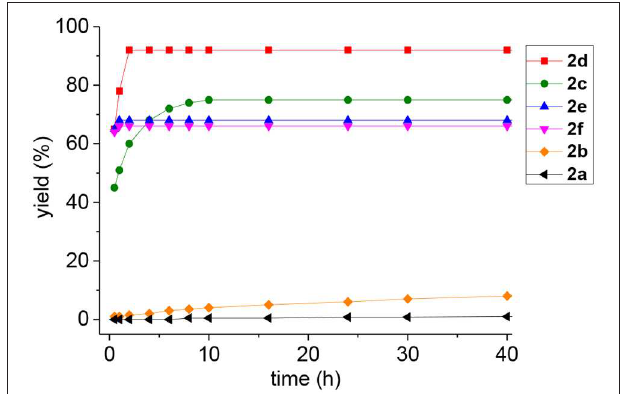
TABLE 1 | Optimization of the active esters for the glycosylation reaction a .